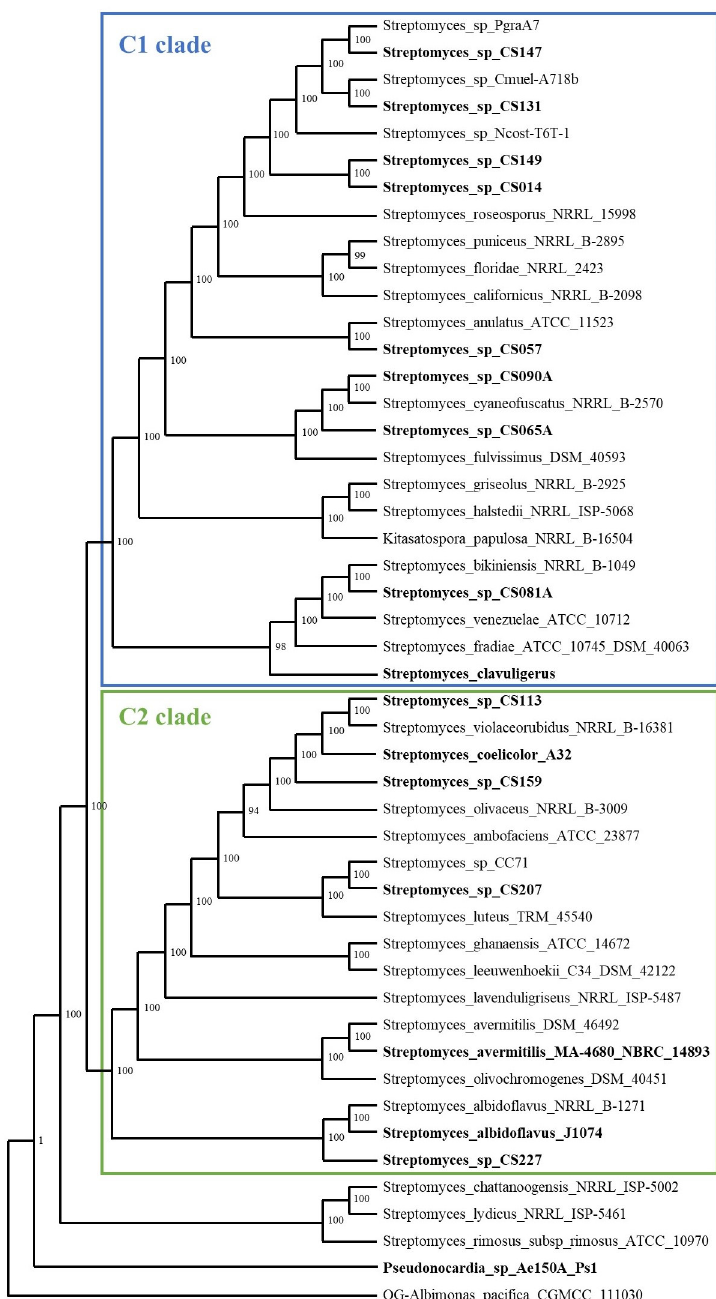
Figure 1. Phylogenetic tree of the concatenated nucleotide sequences of 82 housekeeping genes generated with autoMLST. Strains used in this work are highlighted in